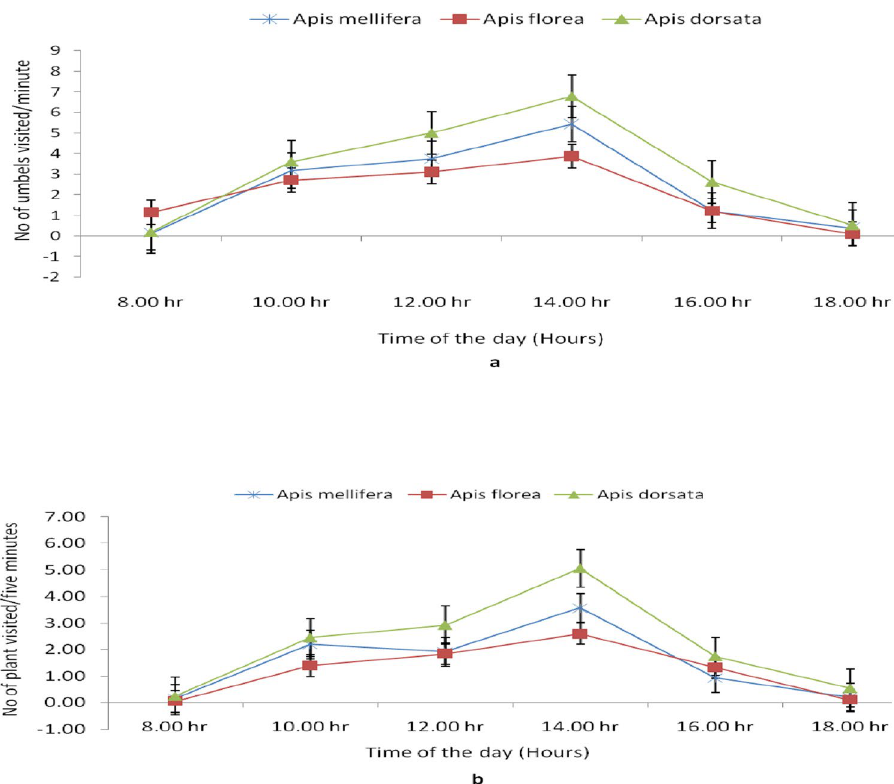
Figure 4. Foraging rates of honeybee pollinators on dill seeds flowers ( a) number of umbels visited per minute, ( b) no of plant visited/five minutes during full bloom in February under semi-arid